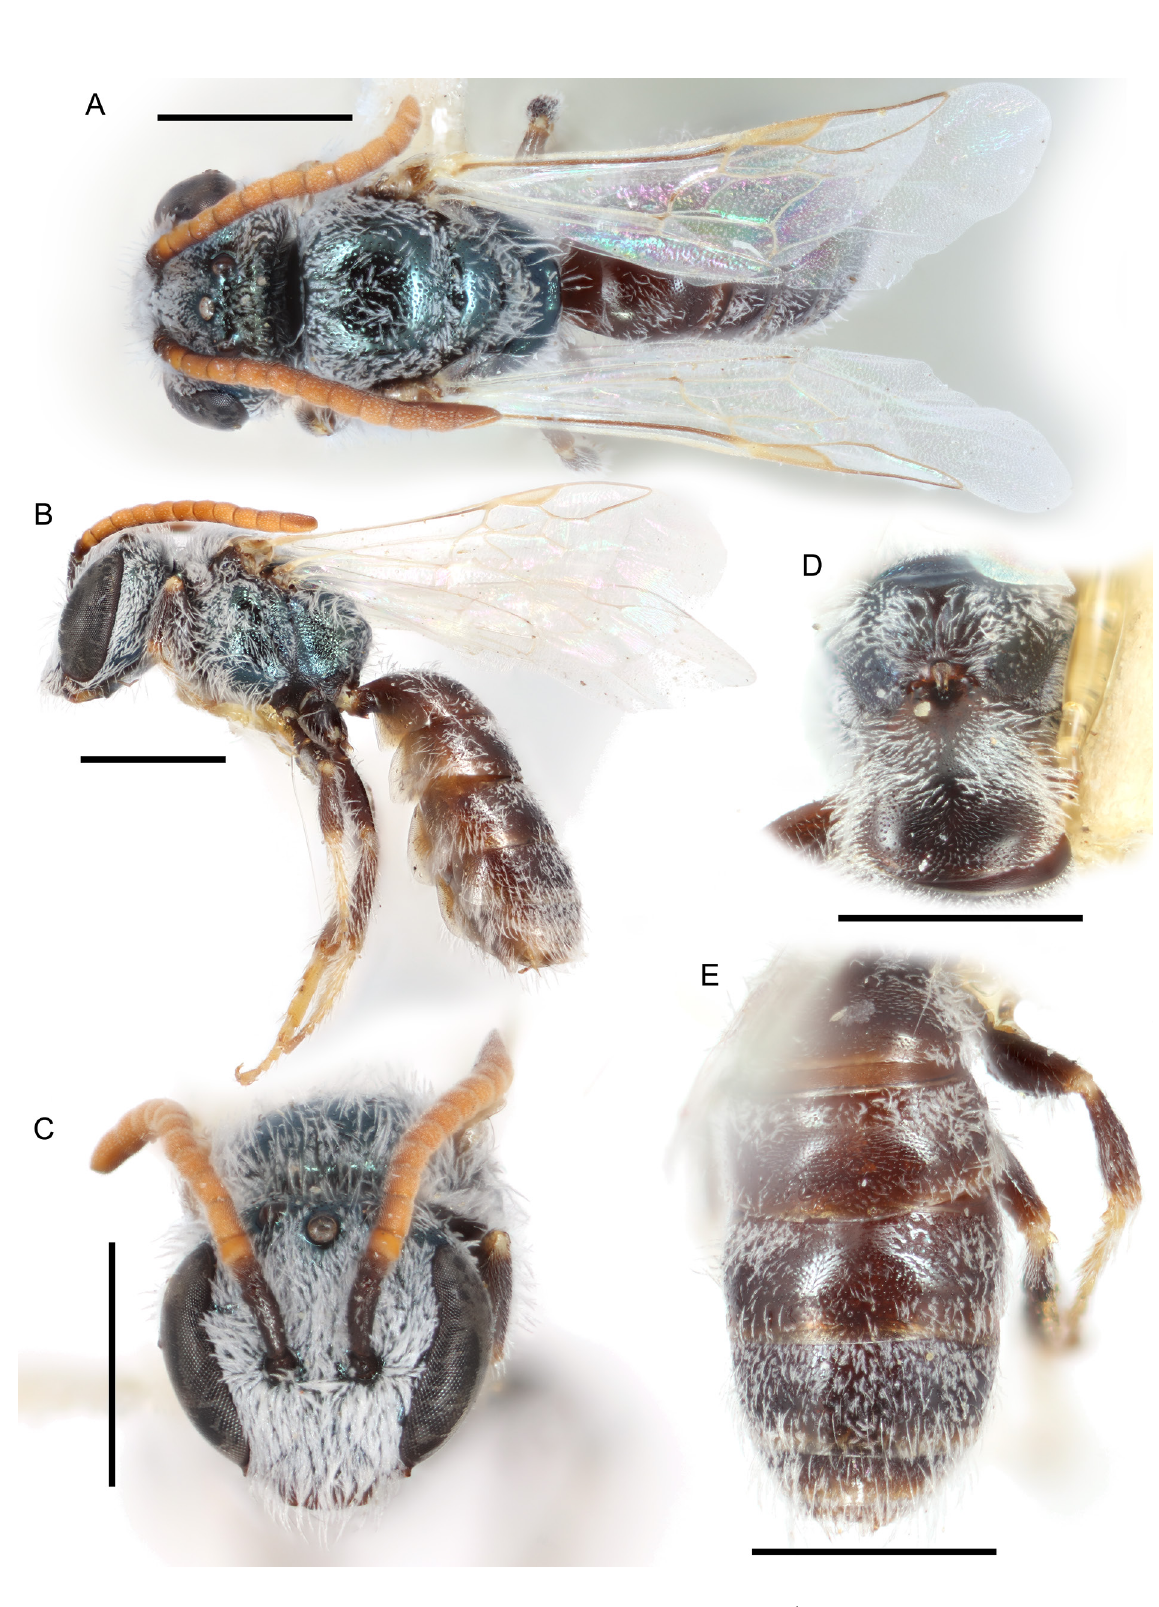
Fig. 68. Lasioglossum ( D. ) pallidellum (Ellis, 1914), dark morph, ♂. A . Dorsal habitus. B . Lateral habitus. C . Face. D . Propodeum. E . Metasoma. Scale bars: 1